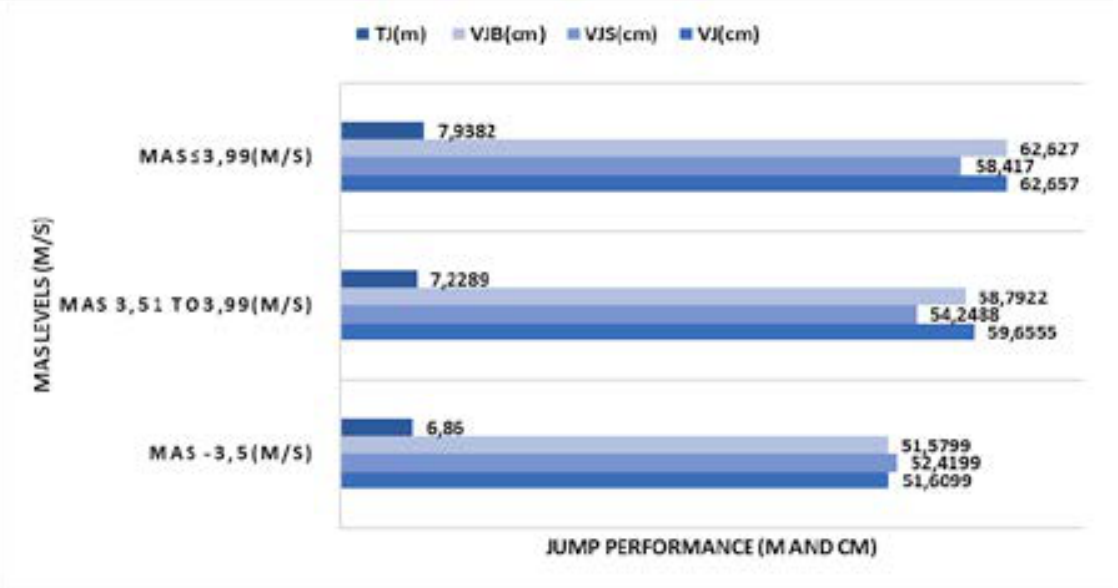
Figure2. Present the levels of Maximal Aerobic Speed (MAS) with jumping Tests used